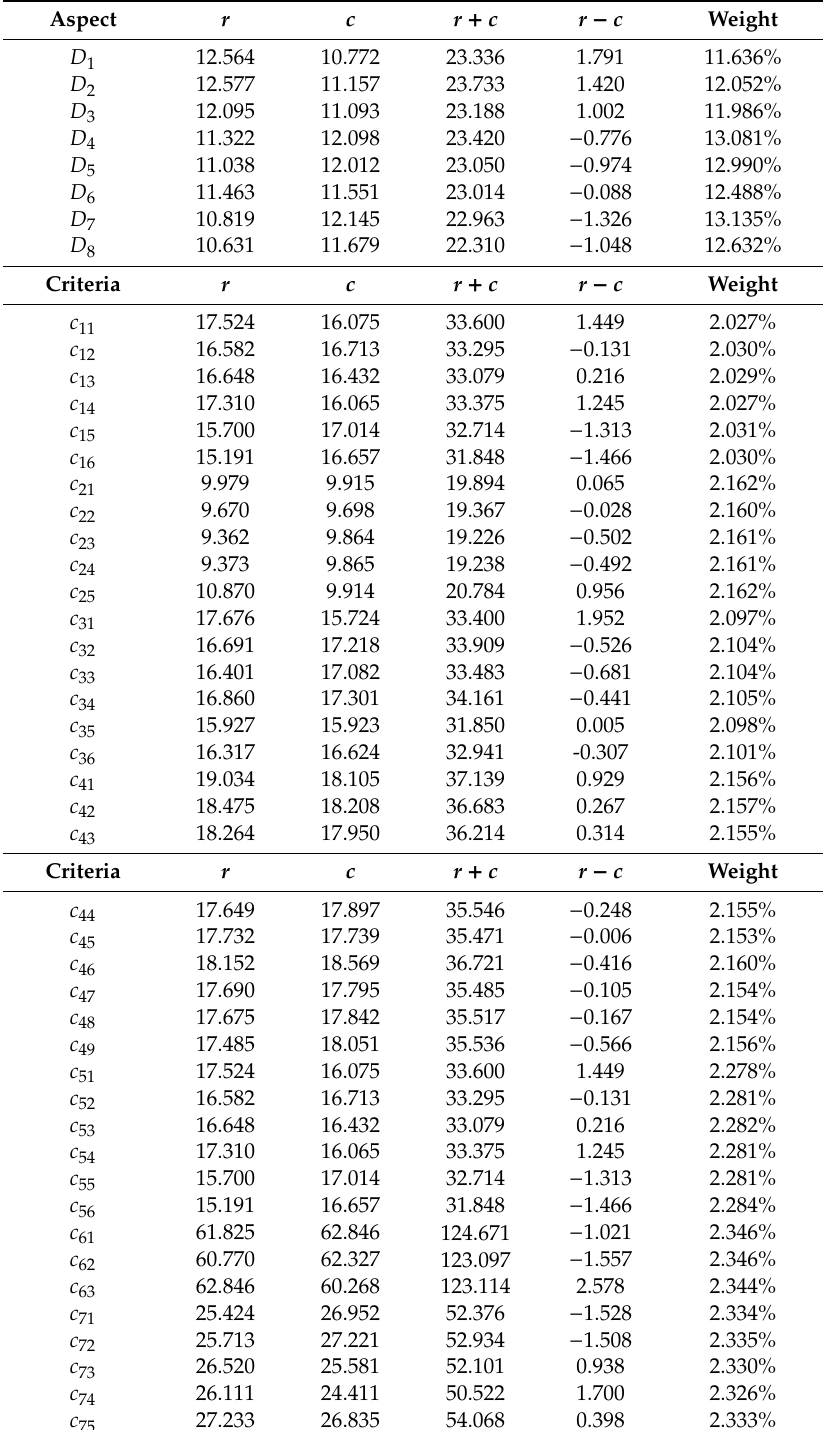
Table 5. The values of r i , c i , r i + c i , r i − c i and weight versus each Aspect and Criterion.